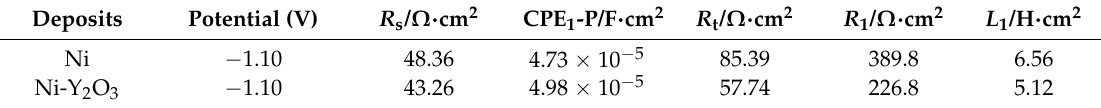
Figure 8. ( a ) Nyquist plots and calculated curves of both deposits measured at − 1.10 V, 40 °C, and pH 4; and ( b ) schematic diagram of the equivalent circuit. Table 3. Electrodeposition parameters of both deposits measured at − 1.10 V.